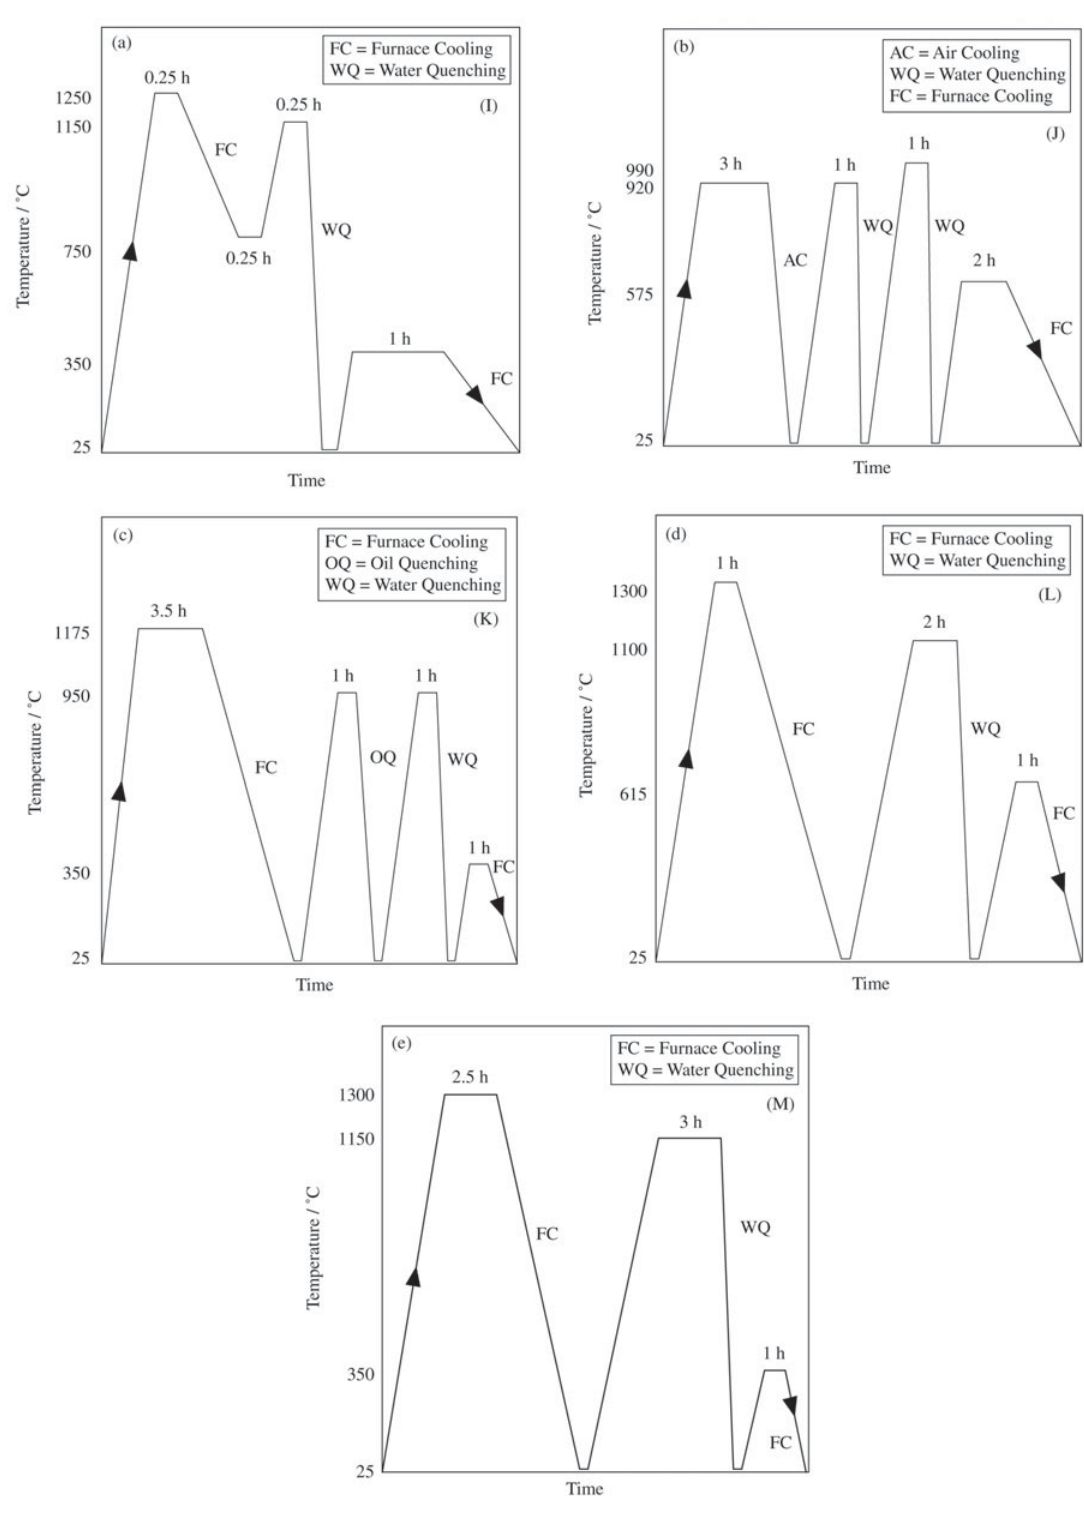
Figure 1. Thermal cycles of the Q&T heat treatments individually applied to the A508 steel in the as-received condition: a) I , b) J ; c) K , d) L and e) M